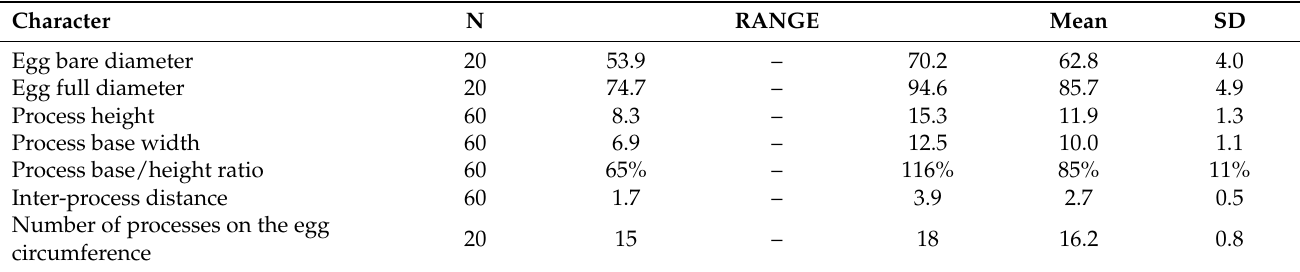
Table 4. Measurements [in µ m] of the eggs of Mesobiotus imperialis sp. nov. ; eggs mounted in Hoyer’s medium; process base/height ratio is expressed as percentage; N—number of eggs/structures measured, RANGE refers to the smallest and the largest structure among all measured specimens; SD—standard